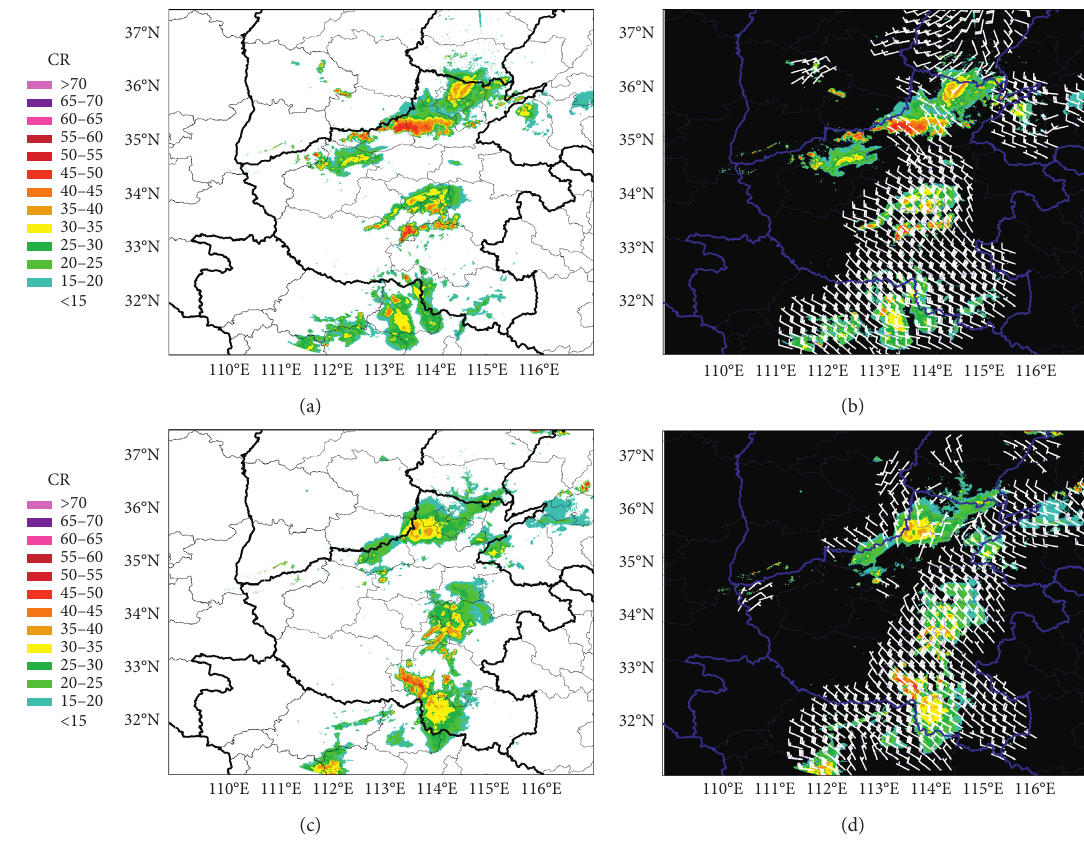
Figure 5: Evolutionary characteristics of the composite reflectivity (a, c) and wind field (b, d) at 1100UTC and 1254UTC July 14 2017. CR